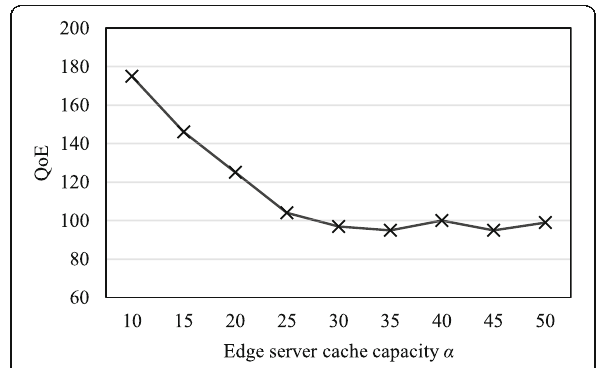
Fig. 7 Relationship between QoE function and edge server cache capacity α Fig. 8 Relationship between storage hit rate and cache capacity α